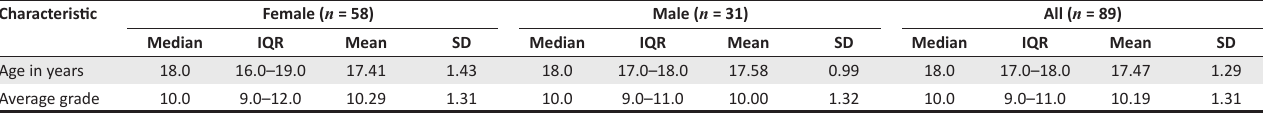
TABLE 2: Age and average grade of participants.